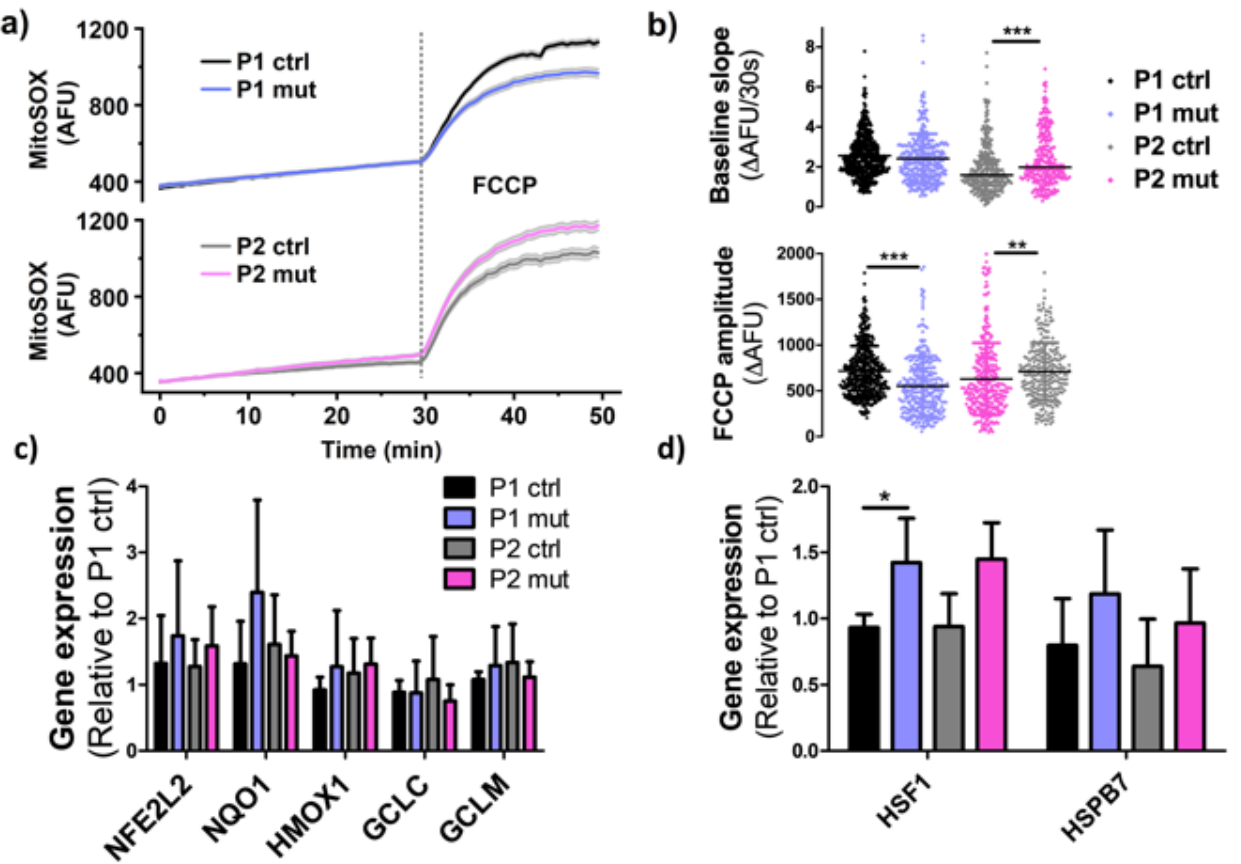
Figure 5. Oxidative stress is increased in the cardiomyopathy patient’s cells. ( a ) Traces of cellular ROS production from developing MitoSOX staining, FCCP introduced at 30 min timepoint. ( b ) Analysis of cellular ROS production by following the intensity of MitoSOX staining at basal state and after FCCP induced maximal respiration P1 ctrl n = 513, P1 mut n = 325, P2 ctrl n = 214, P2 mut n = 265 analyzed cells. Mitochondrial ROS production is increased in P2 cells with high mutation load ( c ) Expression of the NFE2L2 gene (NRF2) and its target genes NQO1 , HMOX1 , GCLC and GCLM relative to one P1 ctrl line. Three independent experiments ( n = 6). ( d ) Expression of heat shock response genes HSF1 and HSPB7 . Relative to one P1 ctrl line. Three independent experiments ( n = 6). * p < 0.05 ** p < 0.01 *** p < 0.001. All results are shown as mean +/-SD.